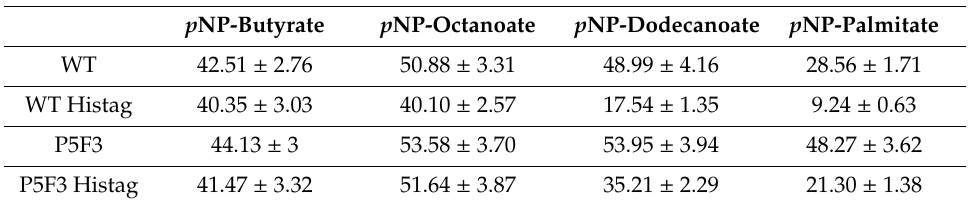
Figure A3. SDS-PAGE of concentrated samples of variant P5F3 and wildtype BSLA. The concentration of BSLA and P5F3 in a 10 kDa mini crossflow concentrated cell supernatant (VivaFlow 200, Sartorius), was estimated through image-based analysis and relative quantitation using a lysozyme calibration curve (Biorad ImageLab). The result was 59.7 µg/mL for P5F3 and 23.0 µg/mL for wildtype BSLA. Table A2. Activity comparison for wildtype BSLA and P5F3 with their corresponding variants containing a C-terminal 6x histidine tag.